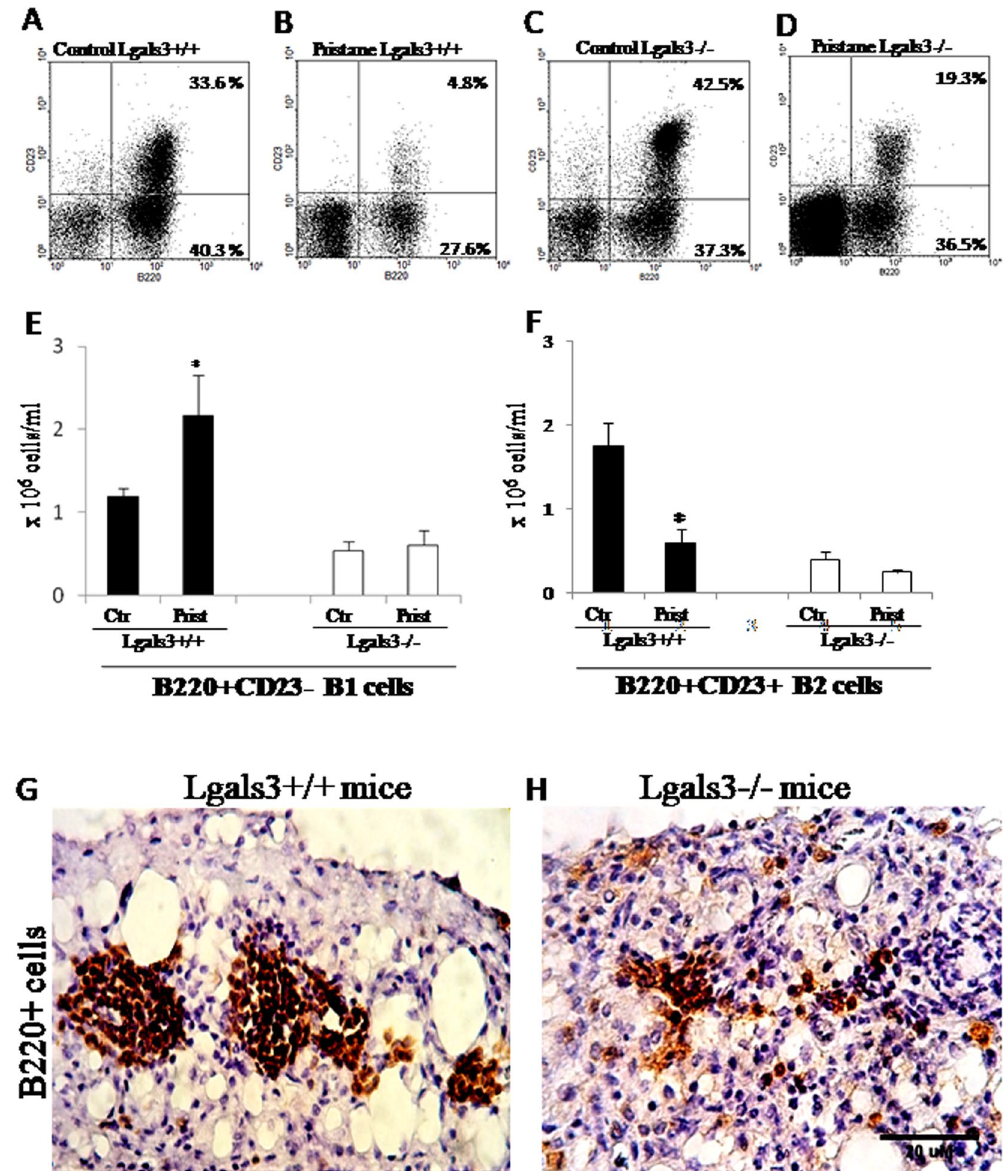
Figure 5. Phenotype of peritoneal-floating B cells and their niches in the mesentery of pristane-induced mice. Dot plot graphs showing B cell subpopulations in the peritoneal fluid of Lgals3 + / + ( A and B , control and pristane) and Lgals3 − / − mice ( C and D , control and pristane). Bar graphs indicate the absolute number of peritoneal B220 + CD23 - B1 cells ( E ) and B220 + CD23 + B2 cells ( F ) in all experimental mice induced by pristane for 18 h. On month 6, mesenteric B220 + cells niches were restricted to organized clusters on Lgals3 + / + ( G ) and dispersed in Lgals3 − / − mice ( H ). Black bars represent Lgals3 + / + mice whereas white bars represent Lgals3 − / − mice 18 h after pristane treatment and respective controls. Data are representative of three independent experiments. G-H: magnification 200 × . ( * ) indicates p <